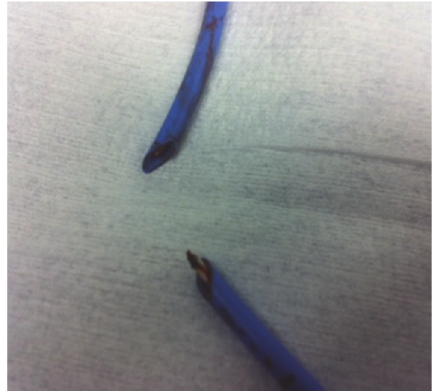
Figure 2: Severed nasal temperature probe.